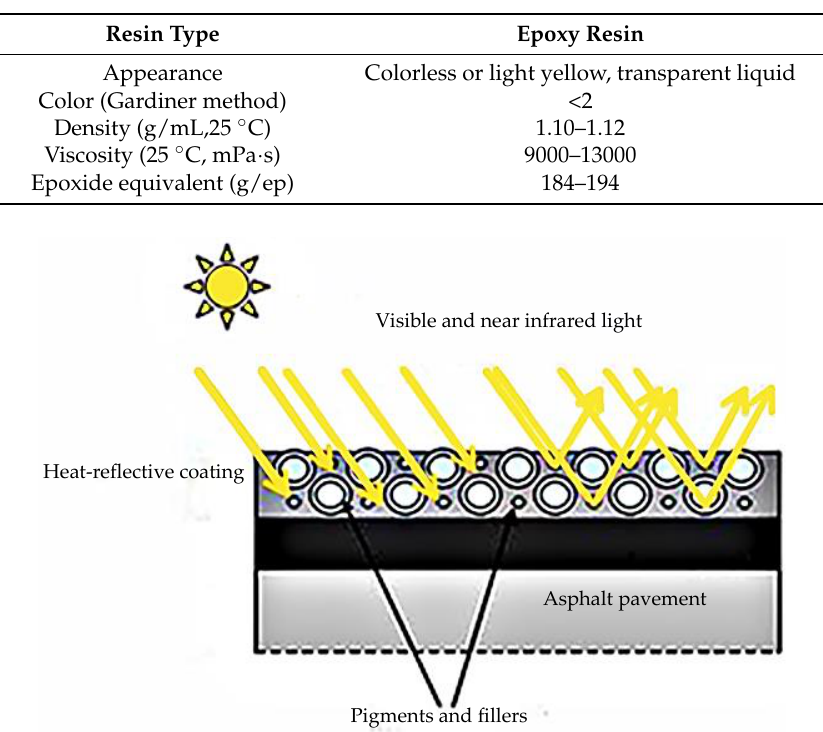
Table 2. Parameters of the resin.